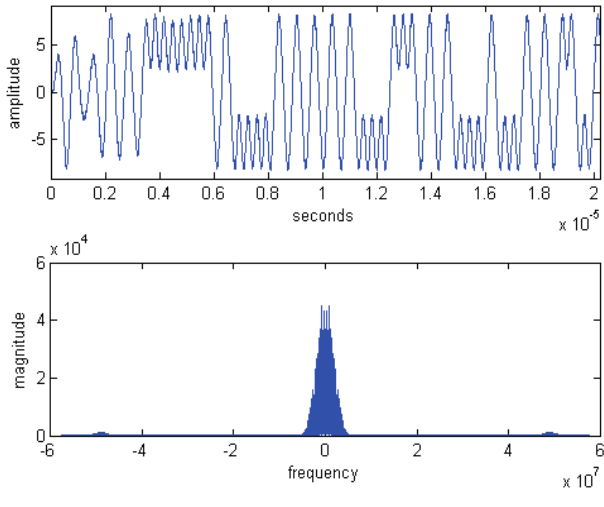
Figure 20. Simulation result of carrier loop.